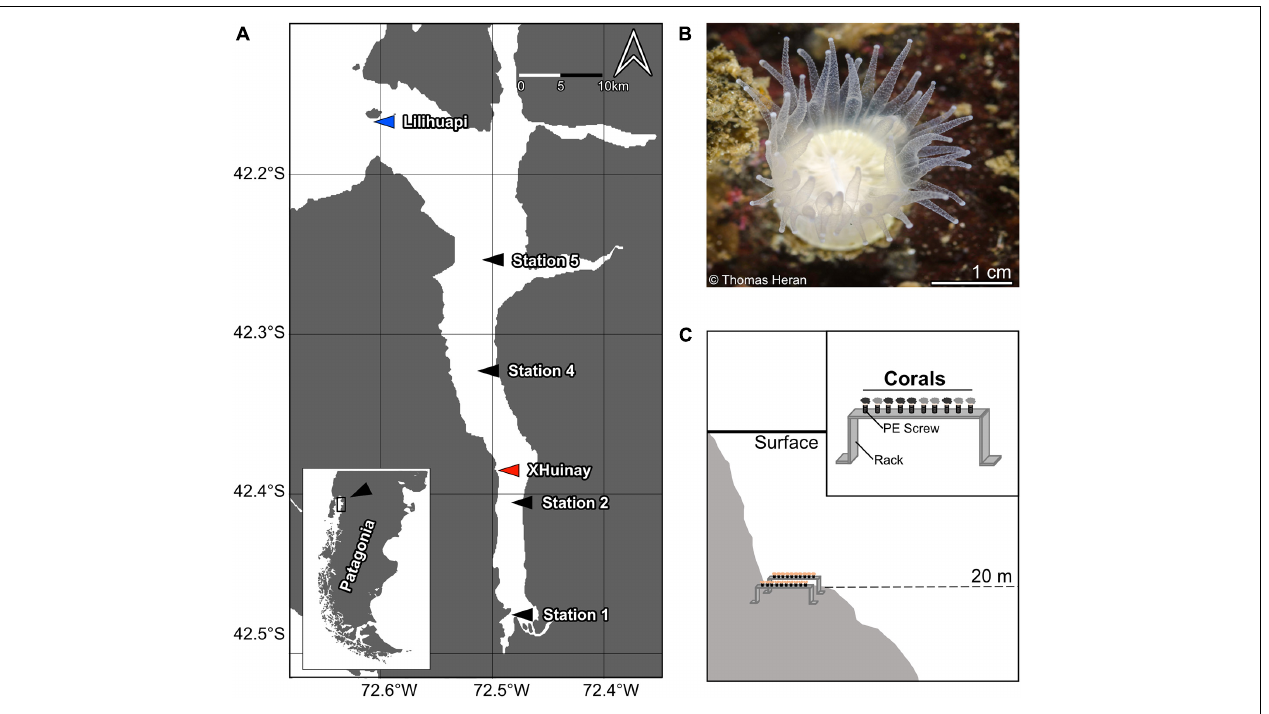
FIGURE 1 | (A) Overview of Patagonian fjord region with Comau Fjord (black rectangle) and 6 CTD stations within the fjord, including the experimental stations XHuinay in the central region of Comau Fjord (red arrow) and Lilihuapi at its mouth (blue arrow). (B) Close-up of a specimen of Tethocyathus endesa (top view). (C) Set-up of coral holder at a depth of 20 m, with coral specimens glued onto polyethylene (PE) screws, which are randomized attached to a mounted rack.